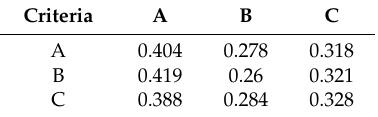
Table 13. Normalized total dimensions relationship